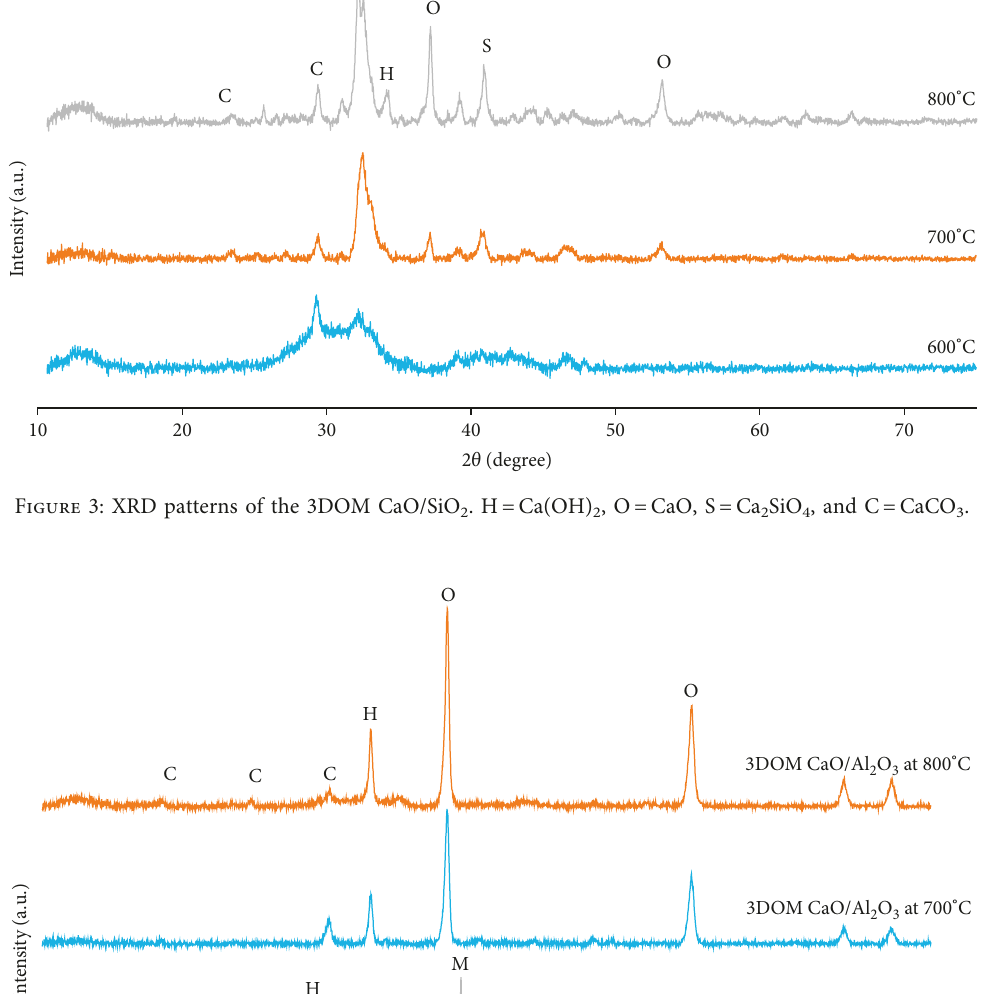
° C and the 3DOM Ca 2 O 3 at 700–800 12 Al 14 O 32 Cl 2 . H (cid:31) Ca(OH) 2 , O (cid:31) CaO, M (cid:31) Ca 12 Al 14 O 32 Cl 2 ,